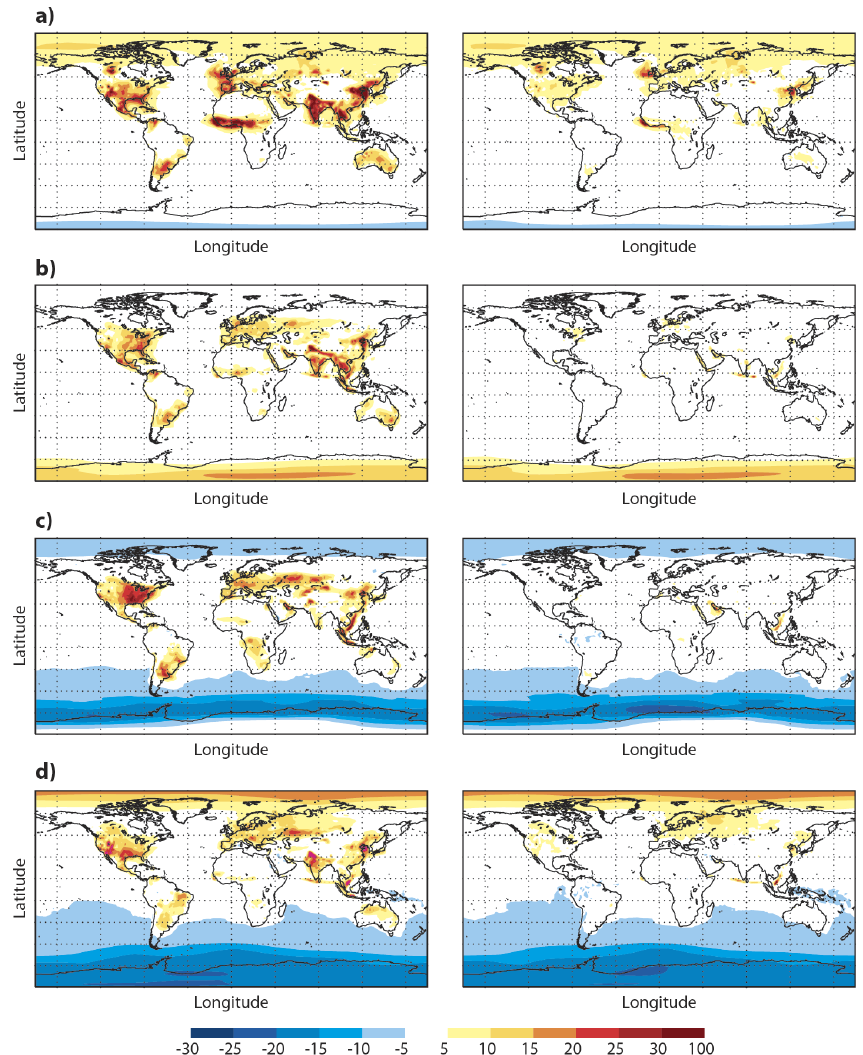
Figure 20. Seasonal mean differences of analysis fields from CIFS-AN minus CIFS-CTRL (left panels) and differences of 12h forecasts from CIFS-AN minus CIFS-CTRL (right panels) in 10 15 moleccm − 2 for (a) JF, (b) MAM, (c) JJA and (d) SON 2008. Red indicates positive values, blue negative